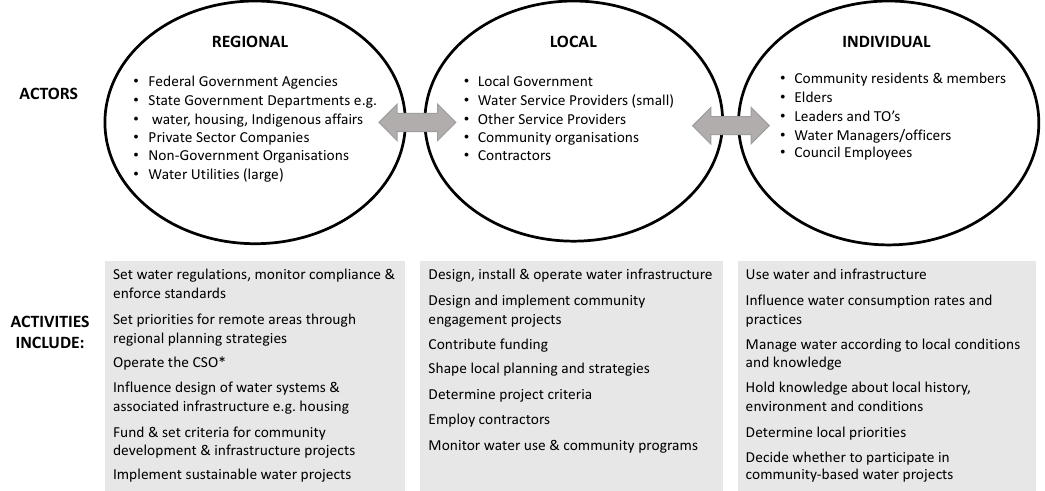
Figure 1. Actors and actions that influence the implementation of collaborative water management in remote Australia (adapted from Vogl et al., 2017 [57]). CSO—community service obligation, a taxpayer funded subsidy to provide affordability equity of services such as electricity and water to remote and rural areas; TO—Traditional Owner, a common title designated to descendants of a tribe that occupied a particular area prior to European settlement of Australia.